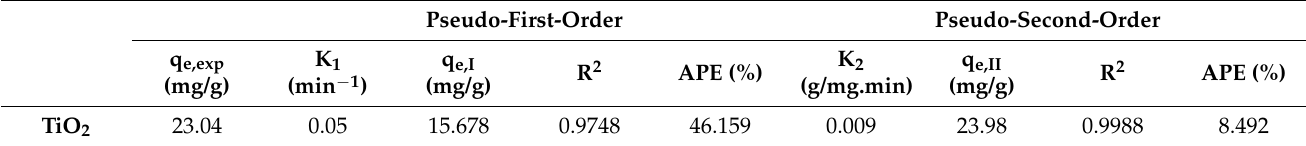
Table 1. Kinetic parameters for MB adsorption onto TiO 2 .